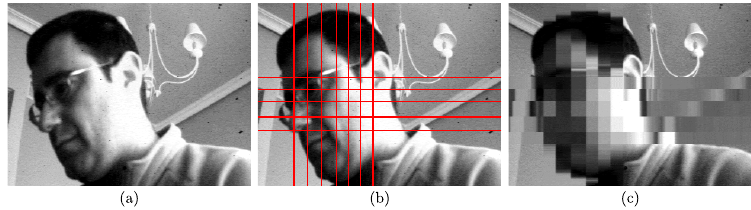
Figure 6. ( a ) Original image captured by the chip. ( b ) Patterns for pixel interconnection. ( c ) Undesired pixelation artifacts out of the region of interest distorting the image